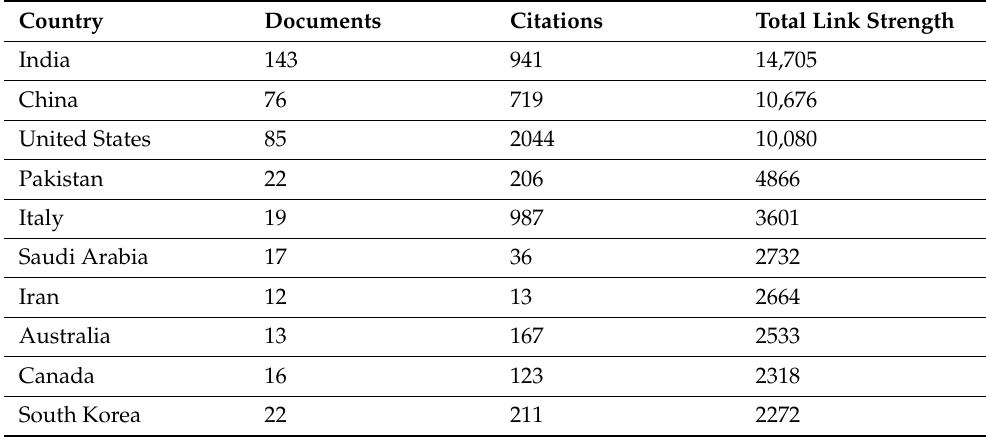
Table 6. Country connections in the